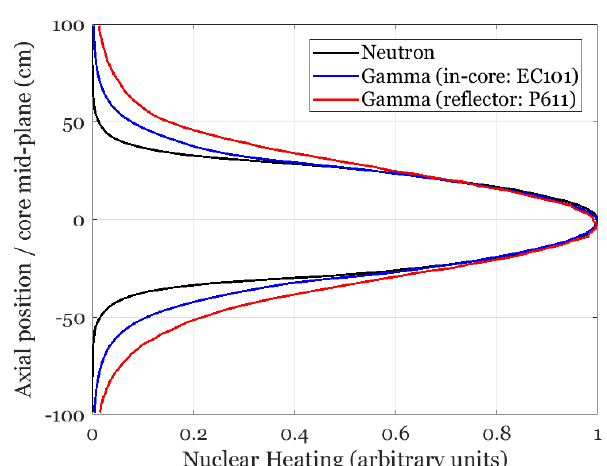
Fig. 8. Axial profile of nuclear heating (neutron and gamma) at the core (for MICA) and at the reflector (for OCCITANE) irradiation